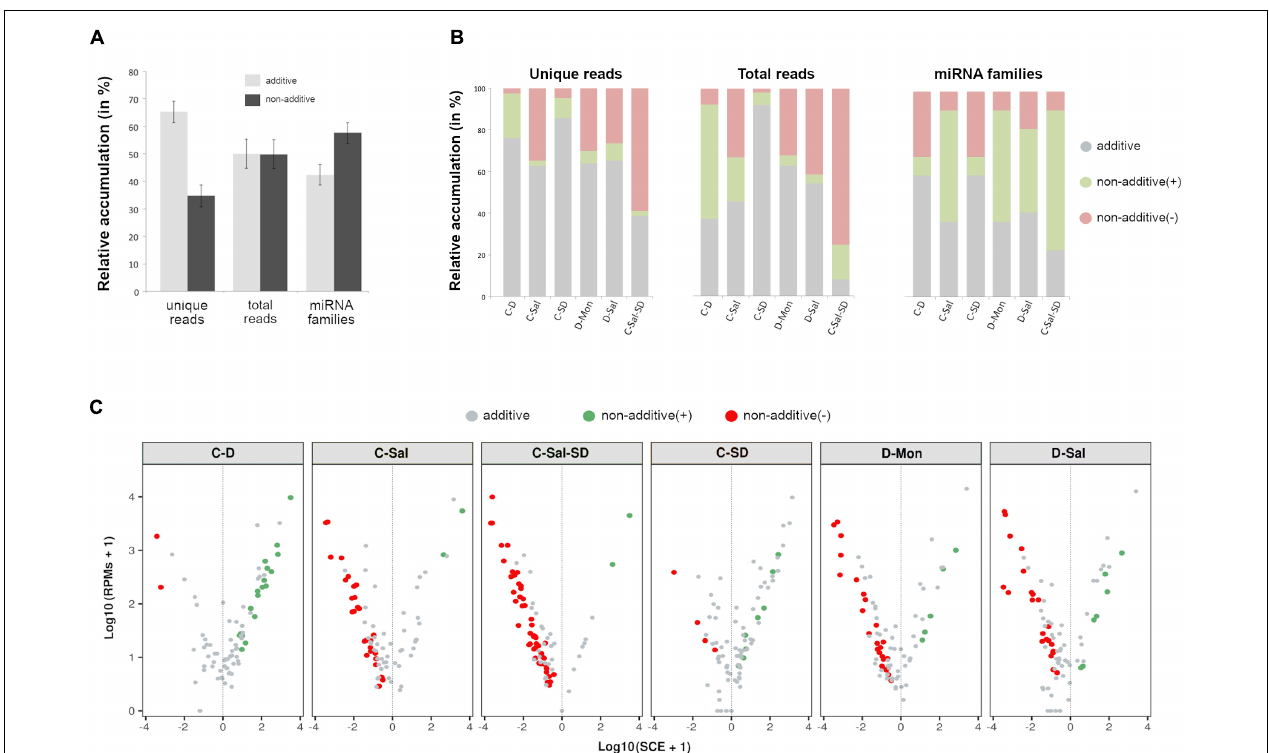
FIGURE 3 | Effects of the stresses combination on the accumulation rate of stress-responsive miRNAs. (A) Graphic representation of the mean percentage for the six analyzed treatments of miRNA-related reads that exhibit additive (gray) or non-additive (black) response to combined stress conditions in comparison to single stresses, considering unique reads (left columns), total reads (central columns), and miRNA families (right). Bars represent the standard error between means. (B) The detail of the global response rate in each stress condition, considering the two (positive or negative) types of possible non-additive response to combined stresses. (C) A volcano plot showing significant positive (green dots) and negative (red dots) SCE values obtained for each miRNA-related read in response to each combined stress condition. miRNAs with non-significant deviations from the additive null model are in gray. More detailed information is provided in the Supplementary Table 6B